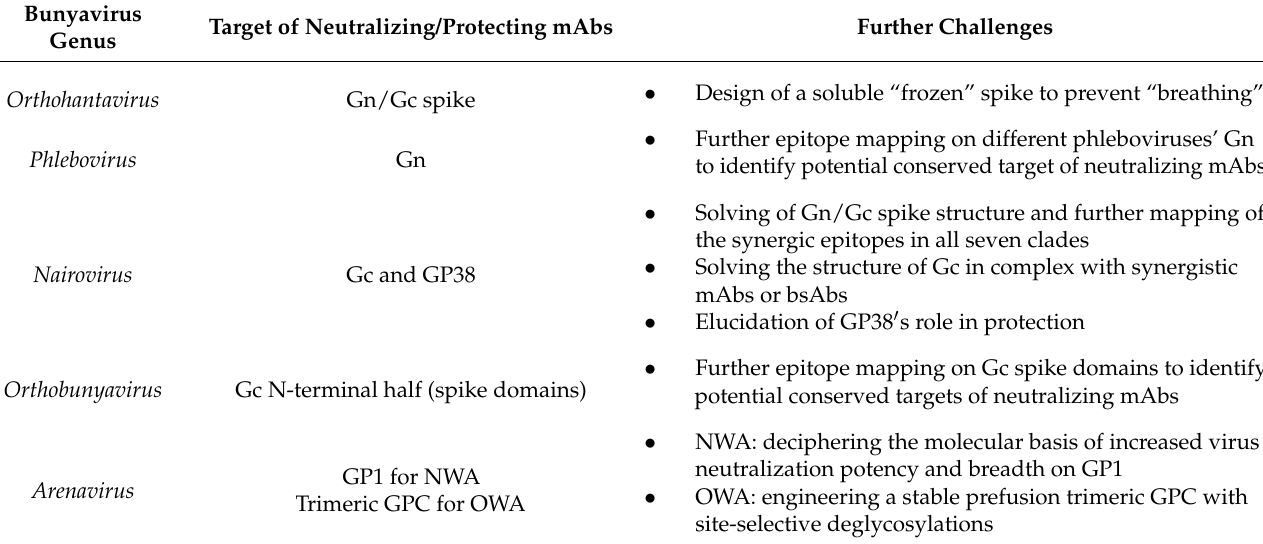
Figure 3. Orthohantavirus and phlebovirus spikes in complex with neutralizing mAbs. ( A ) Modelling of the interaction of Andes virus Gn/Gc spike with two different neutralizing antibodies. Gn is in red, Gc in yellow, Fab 4G2 in blue and Fab HTN-Gn1 in green. Both mAbs were obtained following experimental immunization of an animal model. mAb 4G2 targets Gc whereas mAb HTN-Gn1 recognizes Gn [34,36] (PDB: 6Z06 and 7NKS, respectively). ( B ) Modelling of the interaction of a RVFV pentameric spike with a neutralizing antibody. Gn is in red, Gc in yellow and Fab RV Gn1 in orange. RV Gn1 was also obtained following experimental immunization of an animal model. It targets Gn [37] (PDB: 6I9I). Table 1. Further challenges in structural vaccinology for the design of vaccines against bunyaviruses. NWA: New World Arenaviruses; OWA: Old World Arenaviruses; GPC: glycoprotein